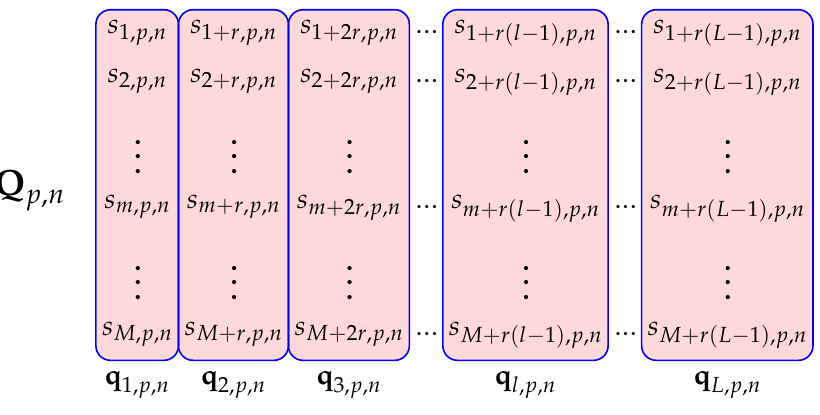
Figure 5. The creation of Q p , n matrix from S E